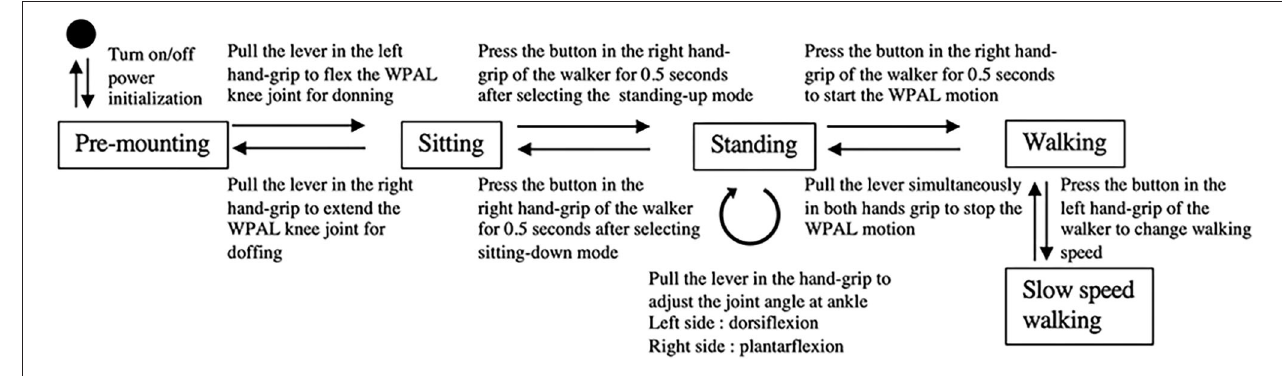
FIGURE 1 | State transition diagram for the WPAL operation. WPAL, Wearable Power-Assist